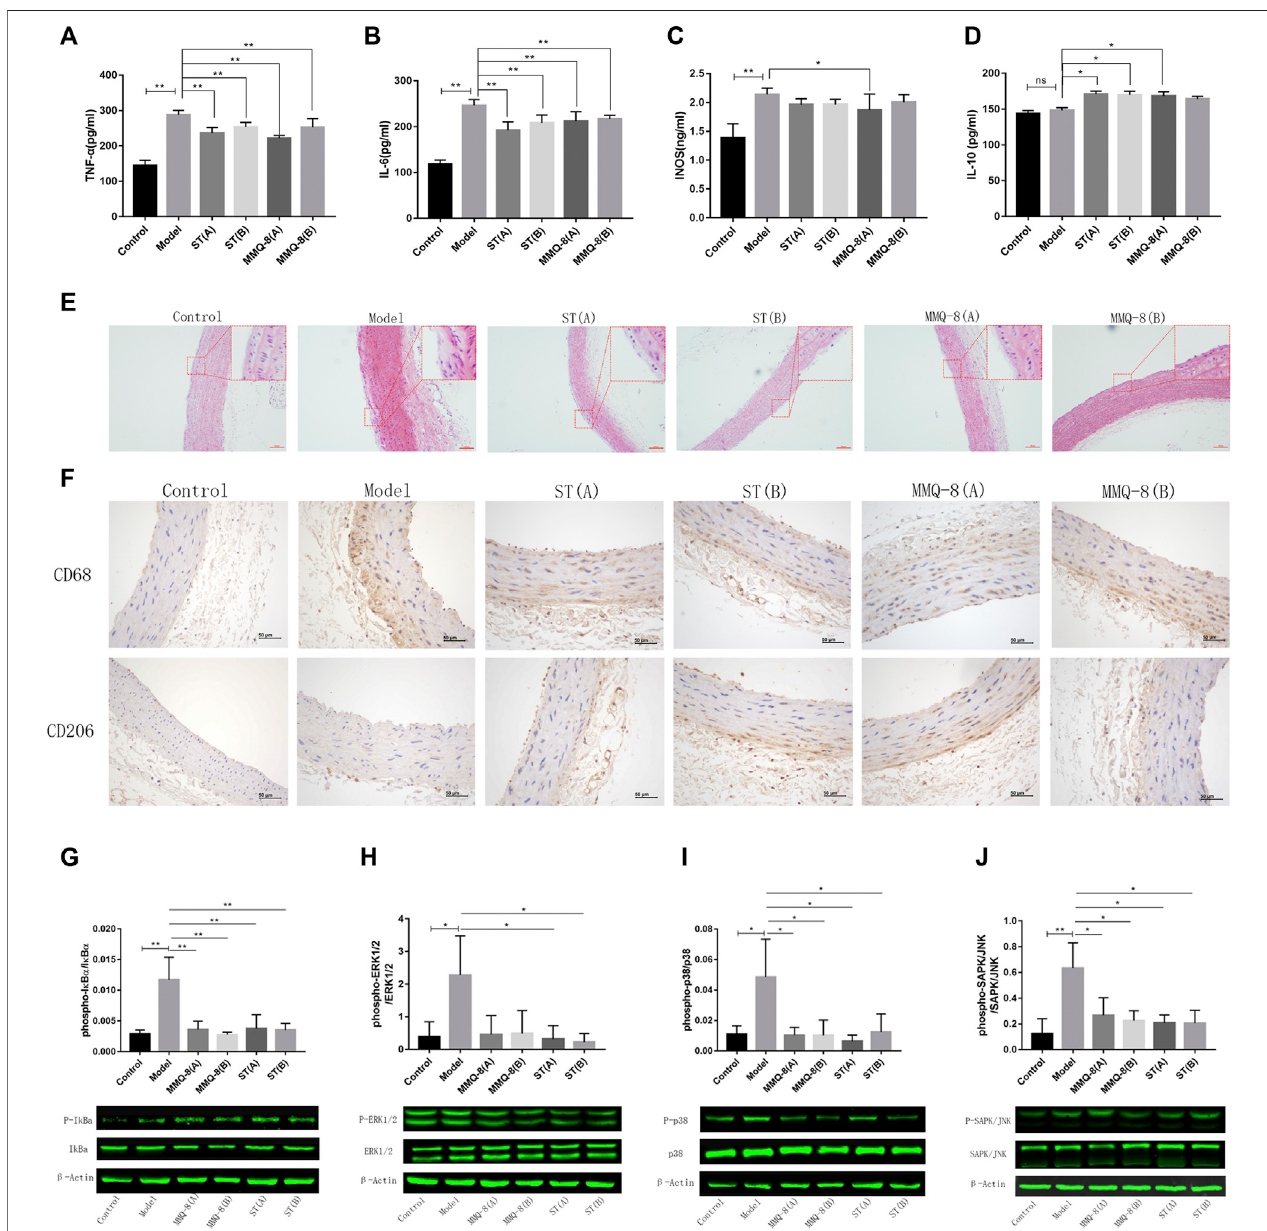
FIGURE 5 | MMQ-8 treatment signi fi cantly inhibited in fl ammation and vascular injury. MMQ-8 treatment signi fi cantly decreased serum levels of pro-in fl ammatory factors TNF- α , IL-6, and INOS and elevated the serum level of anti-in fl ammatory factor IL-10. (A) Serum levels of TNF- α . (B) Serum levels of IL-6. (C) Serum levels of INOS. (D) SerumlevelsofIL-10. (E) MMQ-8treatmentreducedvascularendothelium damage,smoothmusclecellproliferation,andfoamcellformation.Representative H&E staining of arteries ( n = 6). (F) MMQ-8 decreased the number of macrophages and increased macrophage polarization to M2 in artery walls. Representative images of artery immunohistochemistry staining for CD68 and CD206 ( n = 6). (G) MMQ-8 treatment decreased the phosphorylation levels of I κ B α in blood vessels (H) MMQ-8 treatment decreased the phosphorylation levels of ERK1/2 in vasculature. (I) MMQ-8 treatment decreased the phosphorylation levels of p38 in vasculature. (J) MMQ-8 treatment decreased the phosphorylation levels of SAPK/JNK in vasculature. MMQ-8 reduced the vascular protein phosphorylation levels of the TNF signaling pathway in obese rats. Data are presented as means ± SD, n = 3, * p < 0.05, ** p < 0.01.